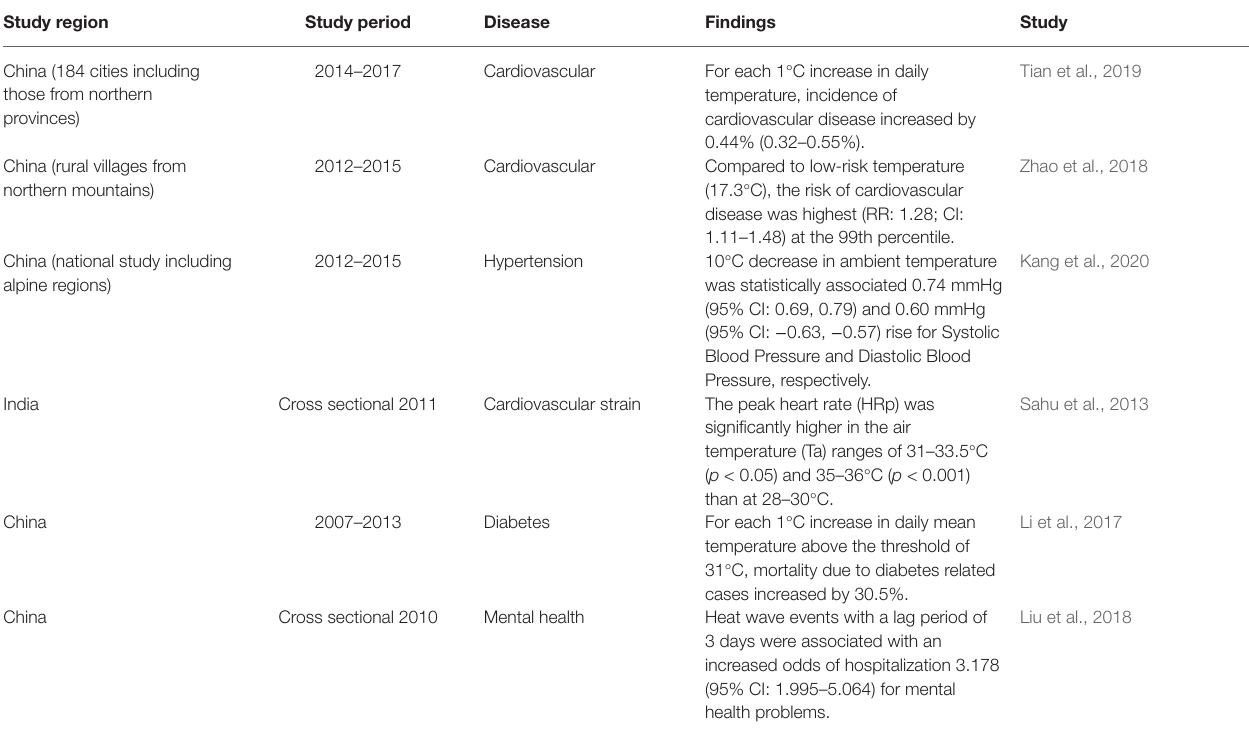
TABLE 3 | Epidemiological evidence on the impacts of climate change (increased in temperature) on non-communicable diseases (NCDs) and mental health in the